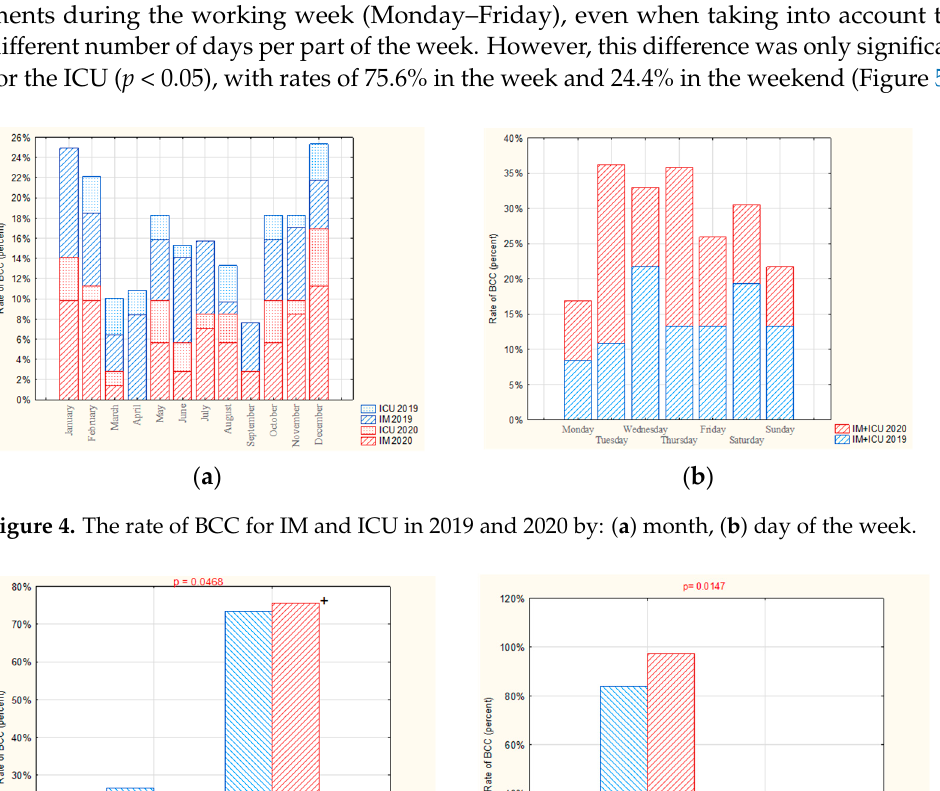
Figure 4. The rate of BCC for IM and ICU in 2019 and 2020 by: ( a ) month, ( b ) day of the week.